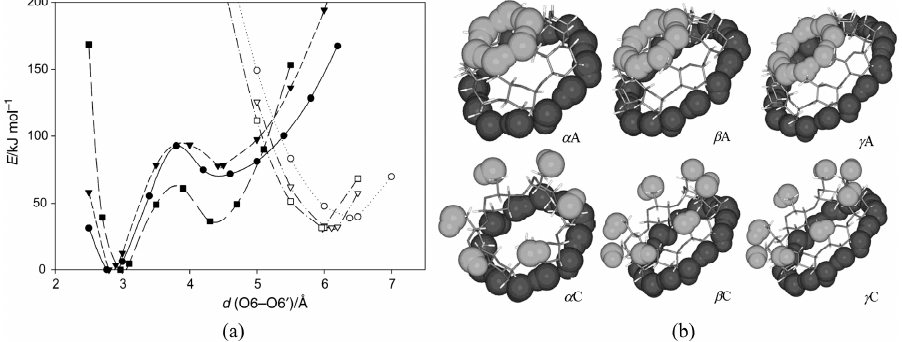
Figure 2. ( a ) Energy profiles of α (circle)-, β (triangle)-, and γ (rectangle)-CDs obtained by varying the O6–O6 ′ distances in the primary hydroxyl groups. The filled and unfilled symbols denote conformers from the A and C series, respectively. ( b ) A and C conformations of α -, β -, and γ -CDs. Reprinted with permission from Springer Nature, Springer-Verlag, Monatsh Chem., Reference [127], COPYRIGHT (2008).